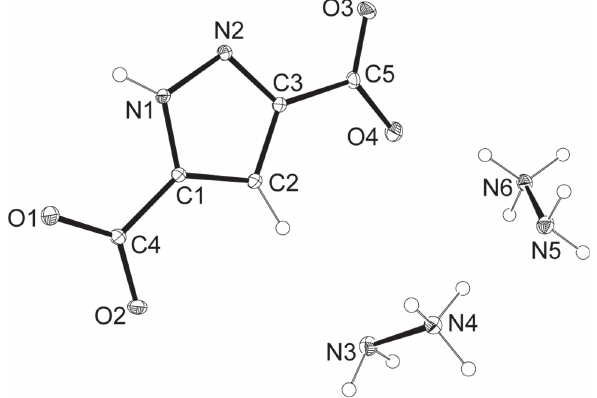
Table 1: Data collection and